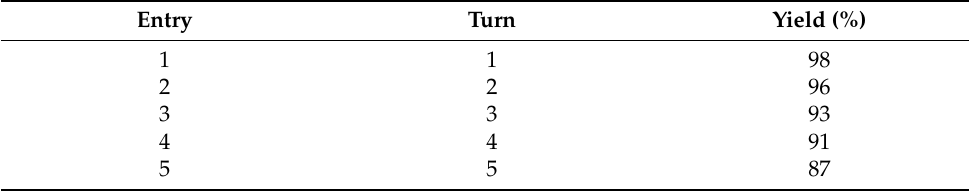
Table 3. Efficiency of the recycled catalyst in the model Passerini reaction.